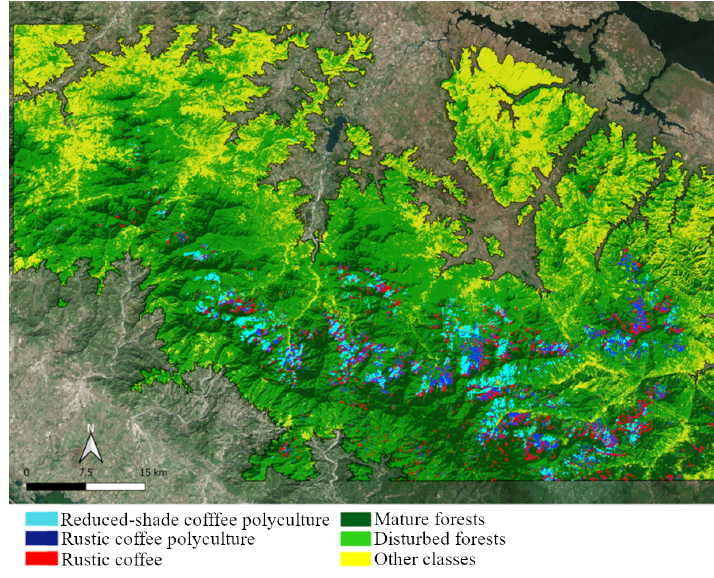
Figure 7. Final map after to overlap all models